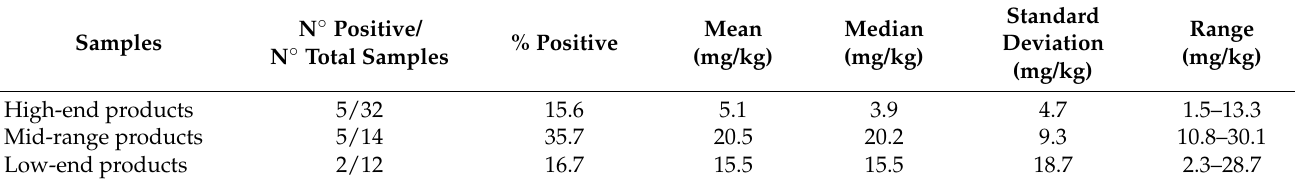
Table 6. Occurrence of histamine in pet-food samples by price range.